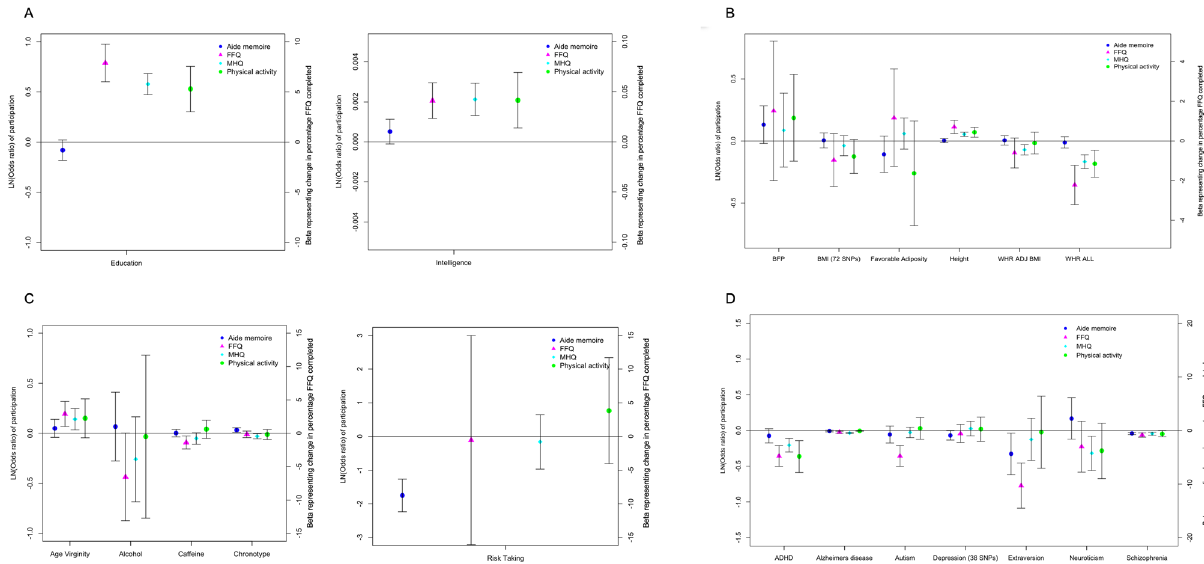
Fig. 1 Plots of the Mendelian Randomisation results. Dot plots representing the inverse-variance weighted results from two-sample MR analyses for ( A ) educational, ( B ) anthropometric, ( C ) behavioural and ( D ) neurological and psychological traits. Error bars represent the 95% con fi dence intervals of the IVW